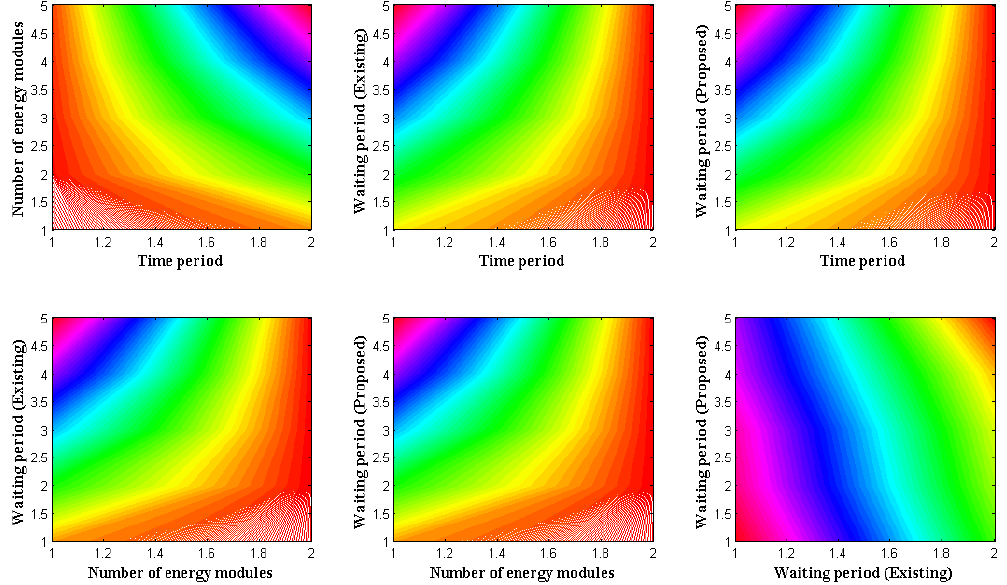
Figure 4. Waiting periods at high energy.